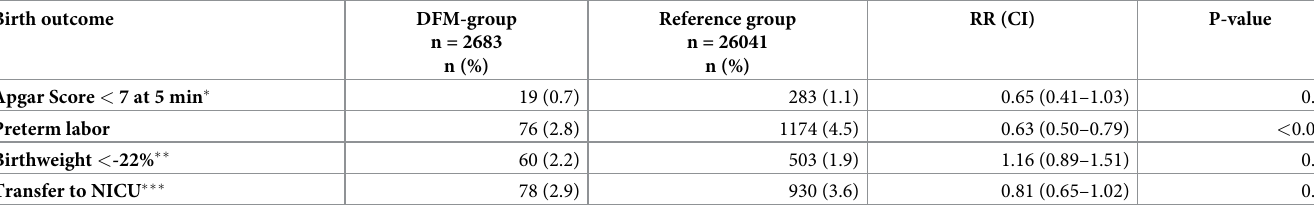
Table 5. Birth outcomes of women in the DFM group in comparison with reference